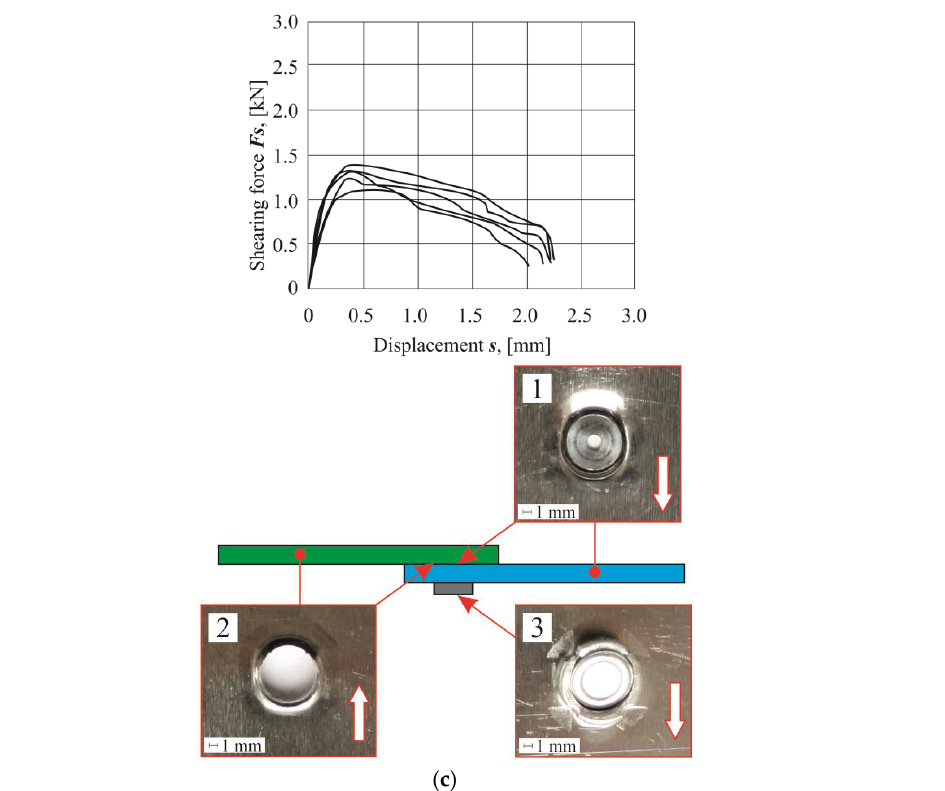
Figure 14. The tensile shear force-displacement diagrams (left side) and joint fragments after tensile shear test: ( a ) arrangement no.1 (AW 5754-H11 with AW 5754-H11), ( b ) arrangement no.4 (AW 5754-H22 with AW 5754-H22), ( c ) arrangement no.7 (AW 5754-H24 with AW 5754-H24).